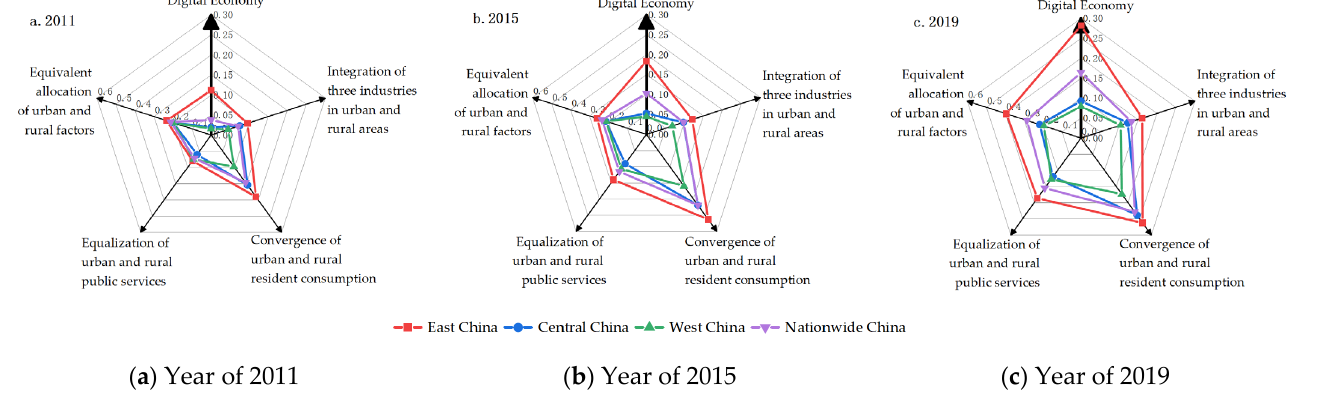
Figure 2. Radar graph.